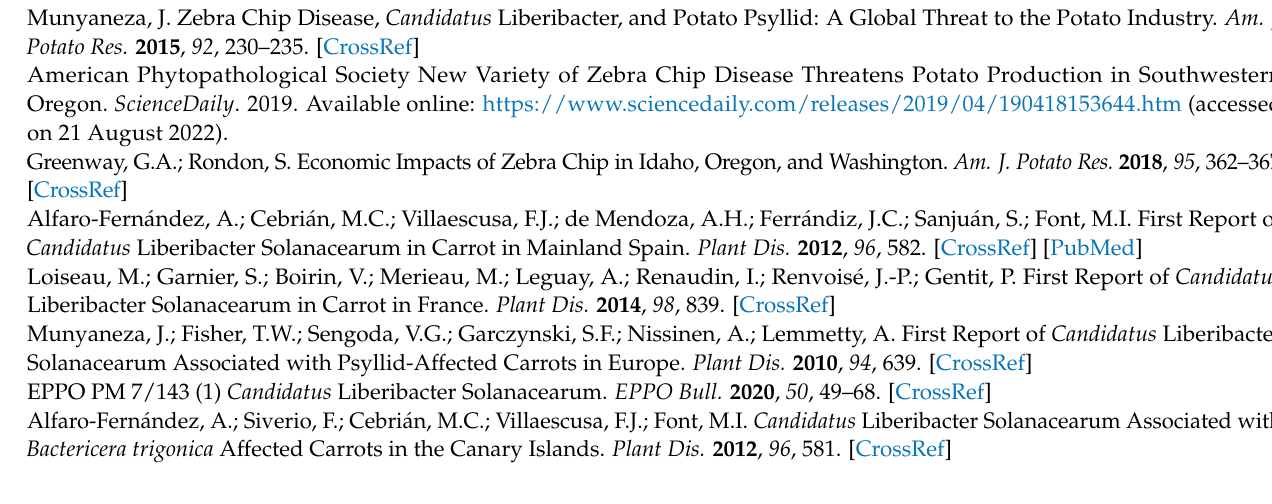
Figure S3: Mean of number of psyllids captured by Irwin traps in Zamadueñas (Valladolid, Castilla, and Le ó n) in 2017; Table S1: Symptomatic and positive plants for CaLsol; mean and number of males and females and percentage of CaLsol+ specimens of Bactericera species captured by sweep net on occasional surveys in potato fields in different production areas in 2016, 2017, and